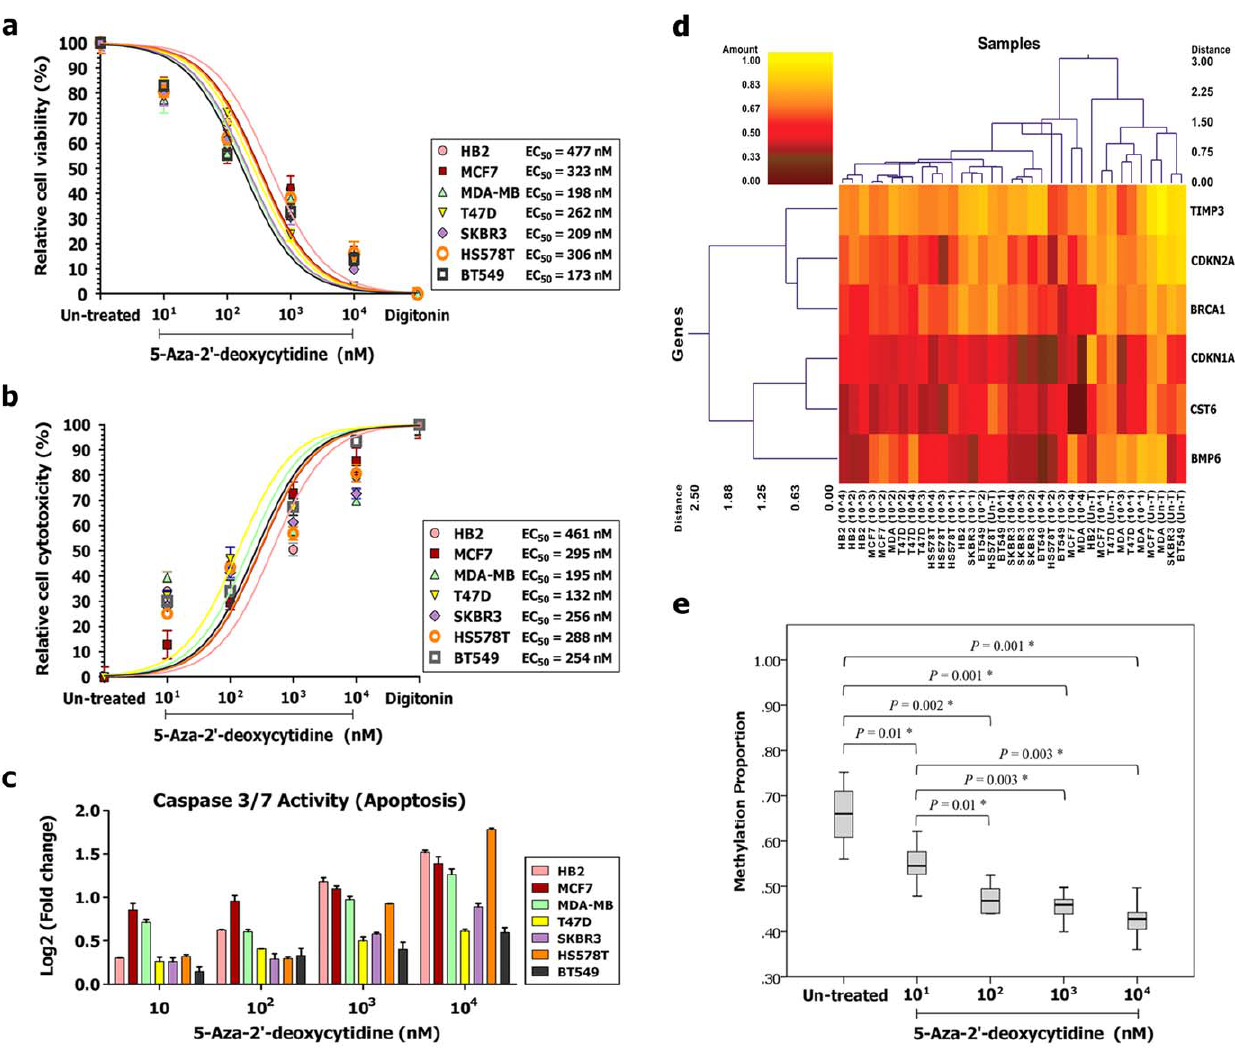
Figure 1. Dose response screening within six breast cancer cell lines (MCF7, MDA-MB231, T47D, SKBR3, HS578T and BT549) and an epithelial breast cell line (HB2) as a control. a-b) Multiplex quantification of the cell viability and cytotoxicity protease activities upon demethylation treatment with DAC (digitonin treated cells were considered as a cell death control). c) Quantification of caspase-3 and caspase-7 activities as a measure of apoptosis. d-e) Methylation profiling of six candidate tumor suppressor genes (red clusters indicate 0% methylated, yellow clusters indicate 100% methylated, color gradient between red and yellow indicates methylation ranging from 0-100, and black clusters indicate not analyzed CpG sites). doi:10.1371/journal.pone.0027355.g001 Table 1. High-throughput methylation analysis of CpG sites per amplicon for the 10 candidate genes.